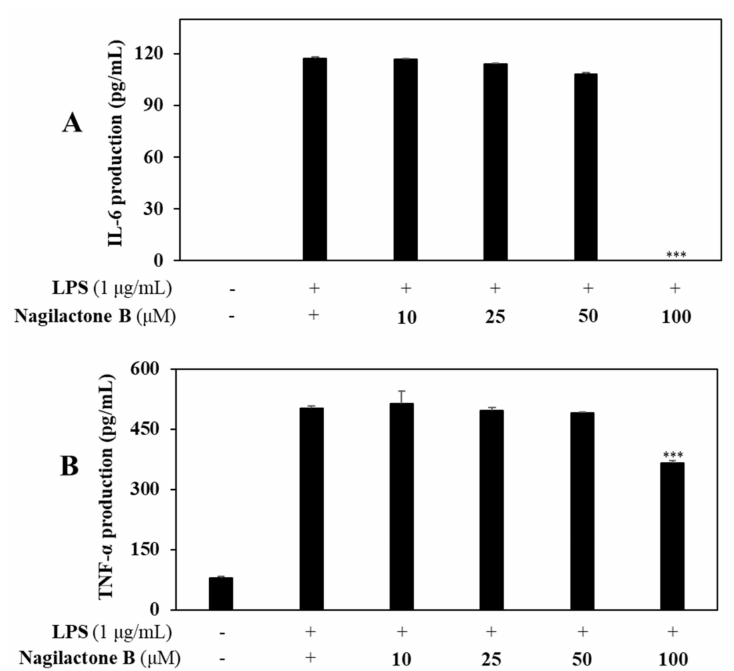
Figure 7. Effect of nagilactone B on the expression of IL-6 and TNF- α . RAW 264.7 cells were treated with nagilactone B (10, 25, 50, and 100 µ M). Levels of IL-6 ( A ) and TNF- α ( B ) in the culture media were measured by ELISA. Cell viability was treated with compounds at the same concentrations and detected using MTT assay. The data are expressed as the mean ± SD ( n = 3). *** p < 0.001 vs. LPS-treated